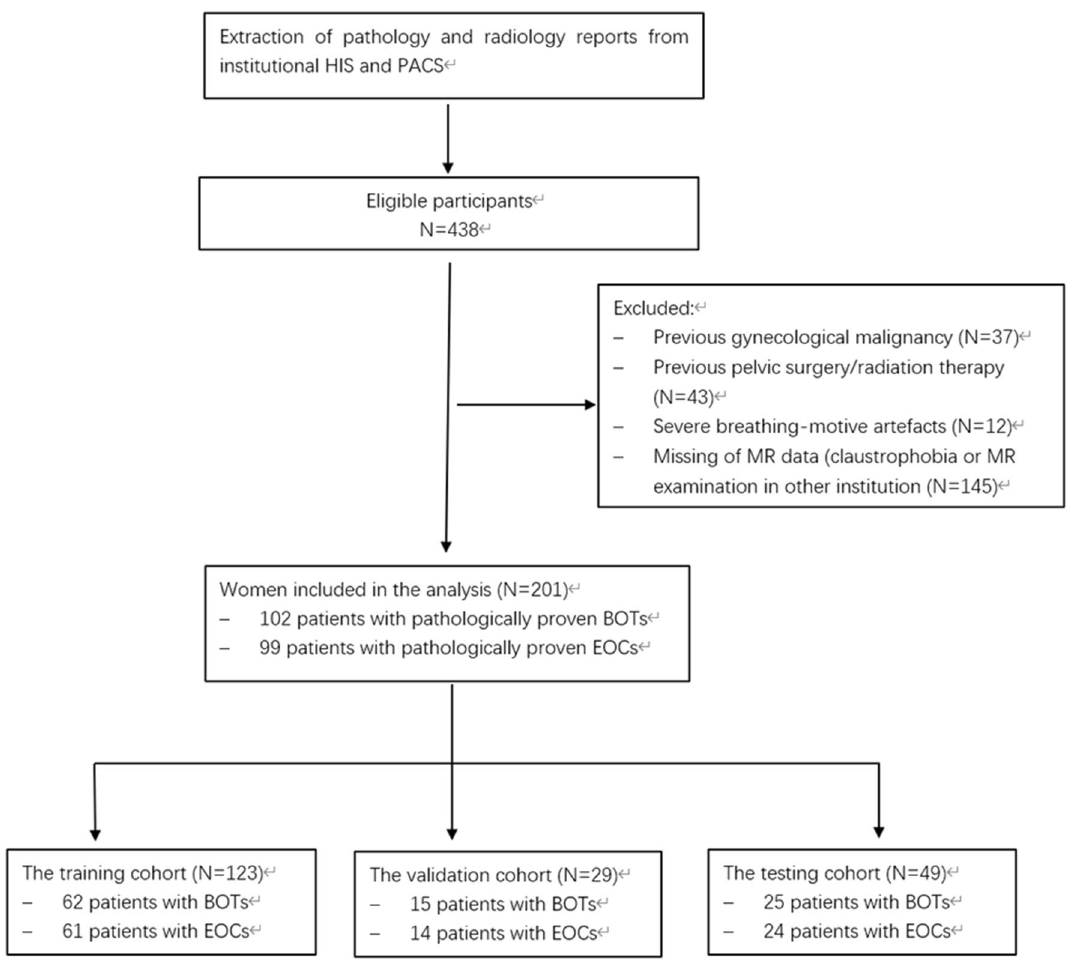
Figure 1. A flowchart about patient inclusion process and exclusion